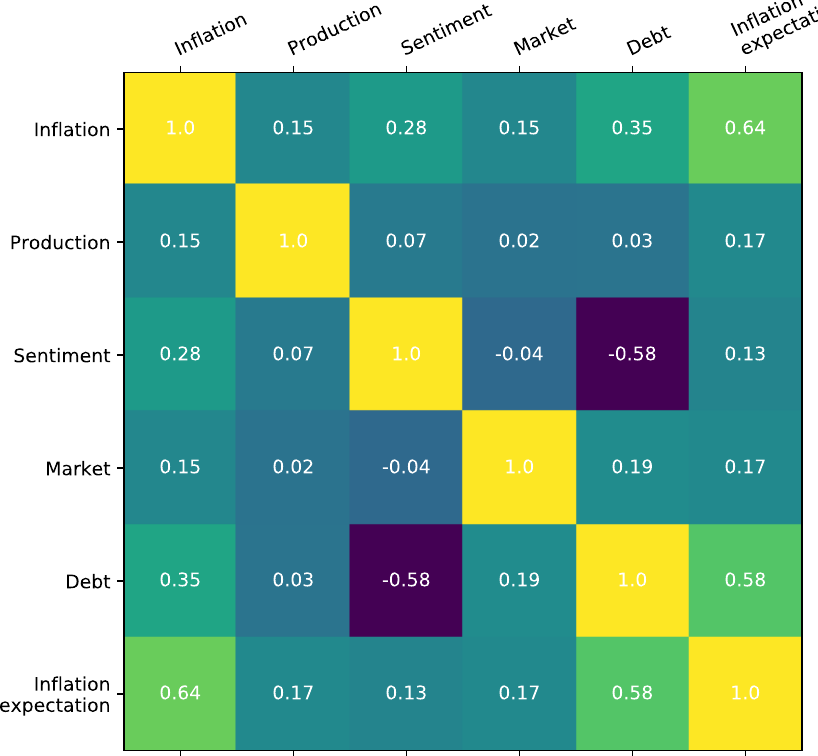
Figure 4. The correlation coefficients of the global economic